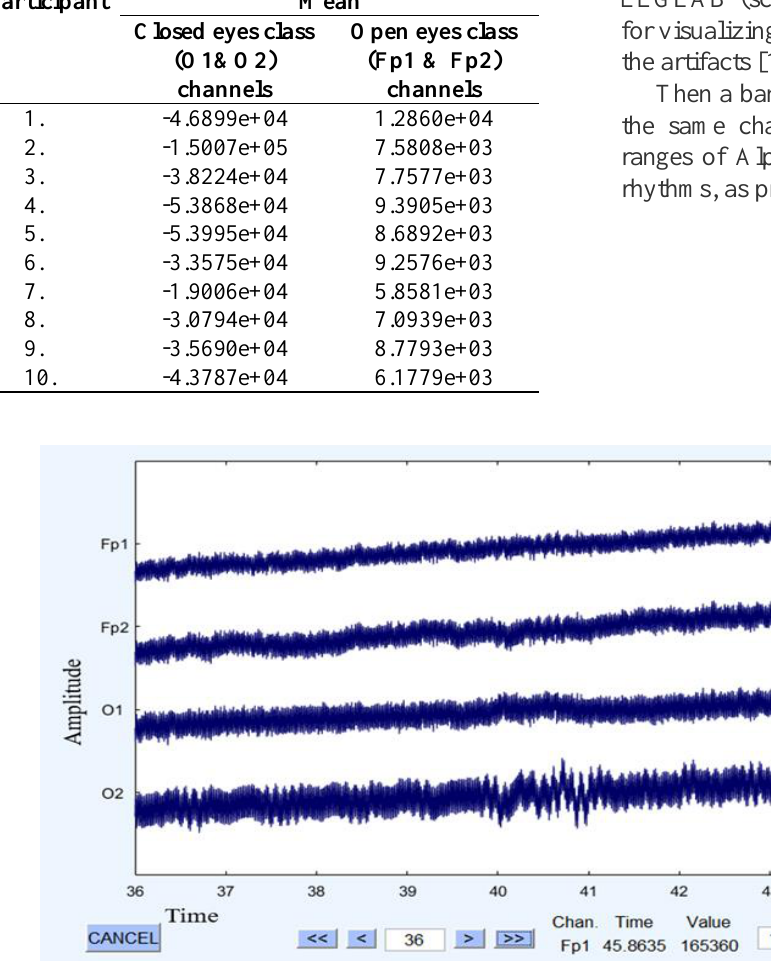
Fig.7. The frontal and occipital channels without